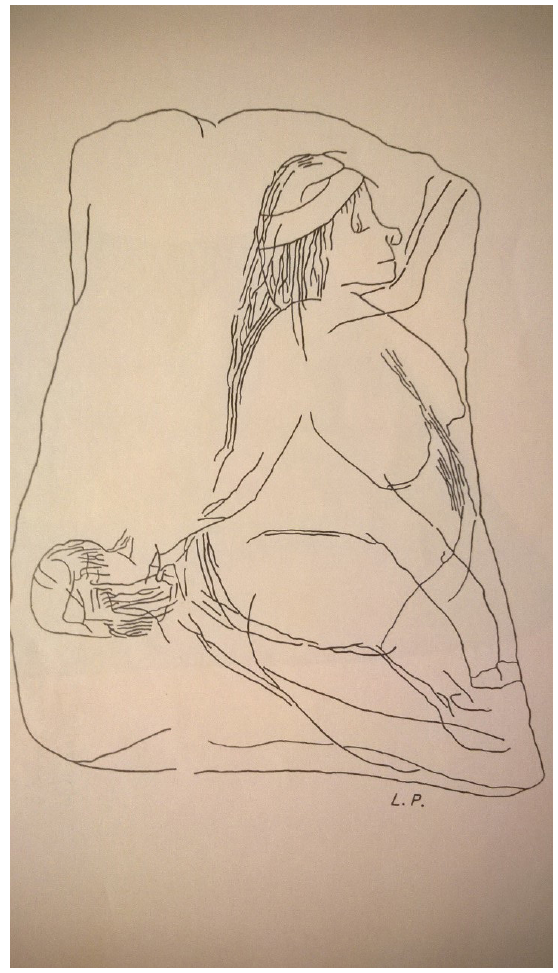
Figure 15. Group α, example of Hand α6: Obs. 38(I) (from Pales, 1976).